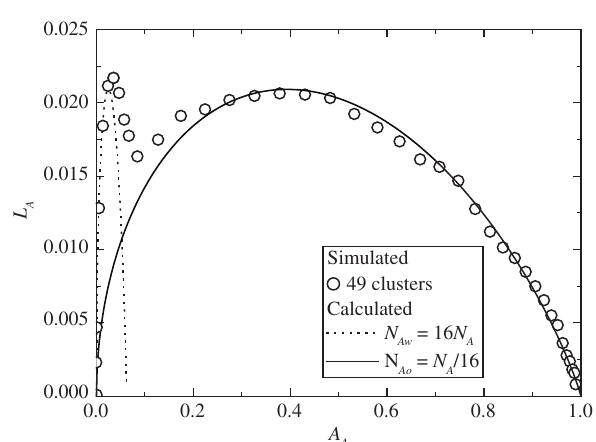
Figure 8. Interfacial area length between recrystallized grains and matrix, L , against area fraction, simulated by CA. Curves are calculated using with A two different values of number of nuclei per unit of area, as explained in the